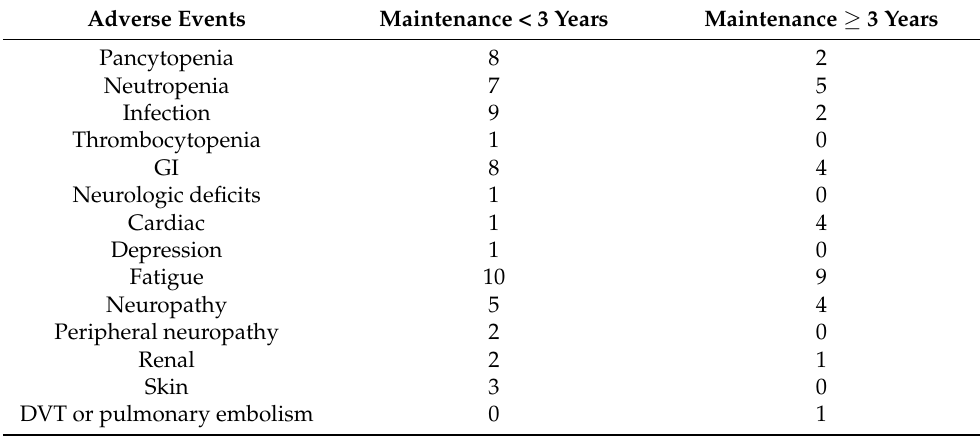
Table 3. Adverse events.